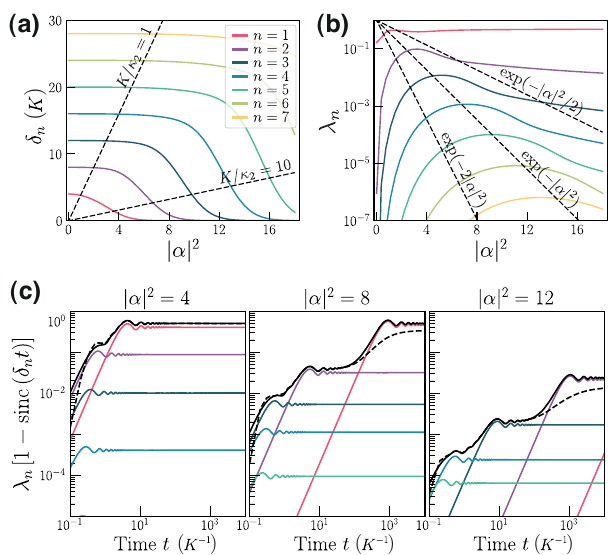
FIG. 2. (a) Energy-level spacing between even and odd par- − e + | in units ity eigenstates of the Kerr Hamiltonian δ n = | e − n n of K . Dashed lines represent the threshold δ n = κ conf at differ- ent values of K /κ 2 . Only eigenstates below this threshold benefit from the additional two-photon dissipation scheme, meaning that /κ (cid:8) 1 in Eq. (4). (b) Relative overlap between the n th pair δ conf n of excited Kerr eigenstates and a cat-qubit state deformed by thermal or dephasing noise (cf. Appendix B). Dashed lines rep- resent the threshold κ l λ n = κ l exp ( − c | α | 2 ) , which one may want to impose with certain values of c in order to achieve exponential suppression of bit-flip errors. All eigenstates above the threshold are susceptible to contribute to a bit-flip rate larger than the target rate via Eq. (4). (c) Individual terms of the sum of Eq. (3) with respect to time. The solid black line represents the sum of all terms. The dashed black line represents p X ( t )/κ l t extracted from a numerical simulation of Kerr confinement with single-photon loss κ 1 = 10 − 3 K and thermal noise n th = 10 − 2